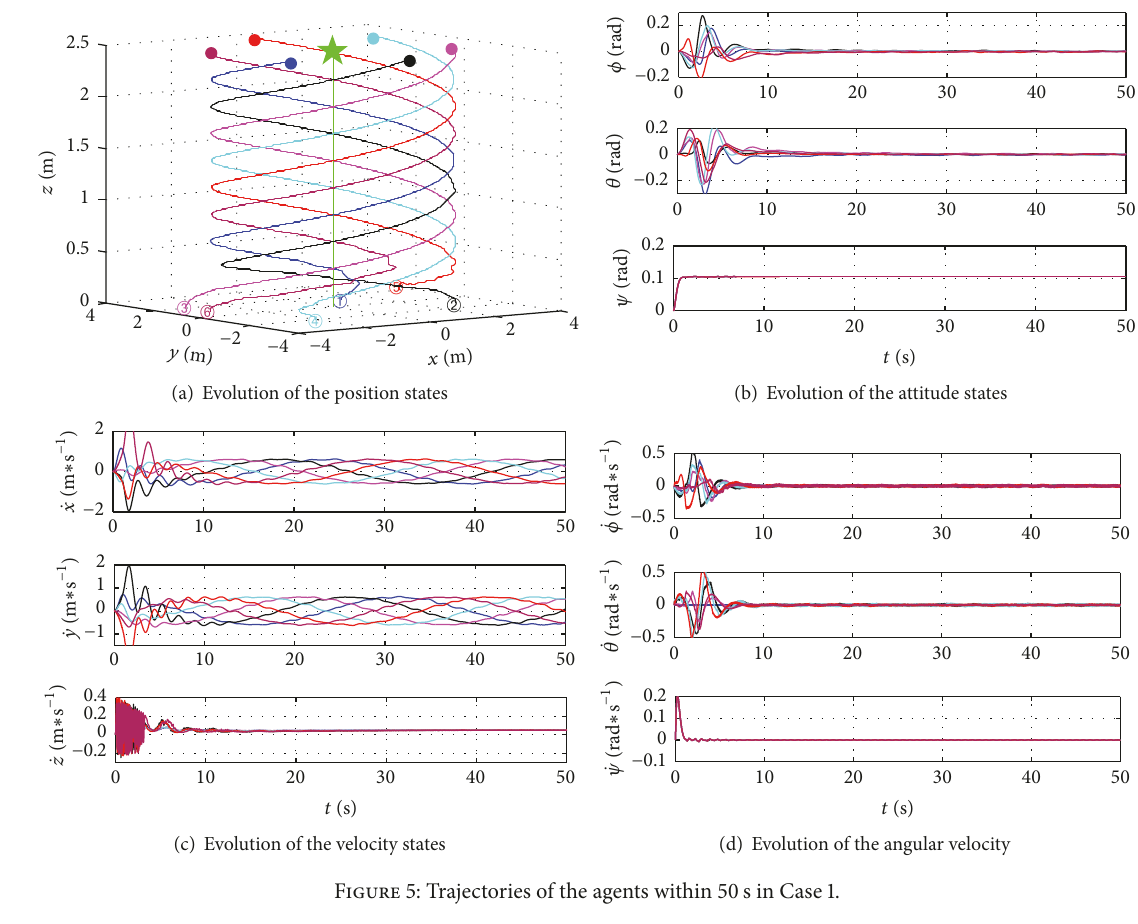
Figure 5: Trajectories of the agents within 50 s in Case 1.